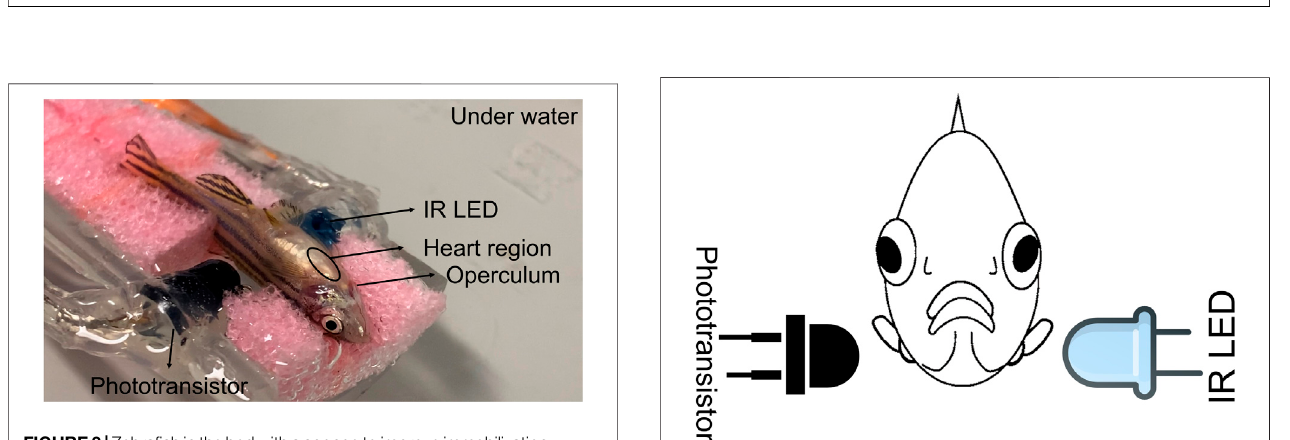
Frontiers in Physiology |